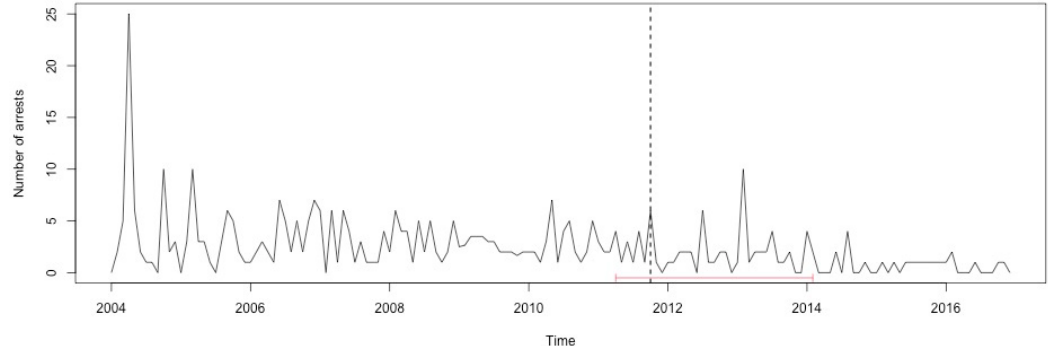
Figure A43. Heroin foreign nationals arrests 2004–2016 in the Czech Republic and structural breaks.